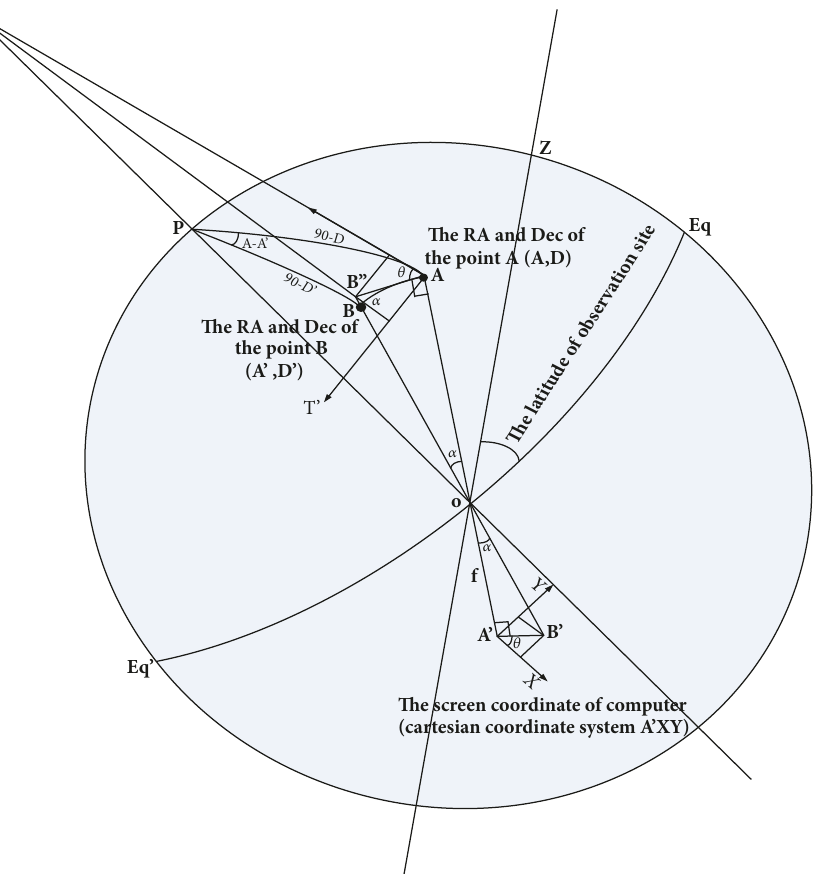
Figure 6: The coordinate transformation between Cartesian and equatorial